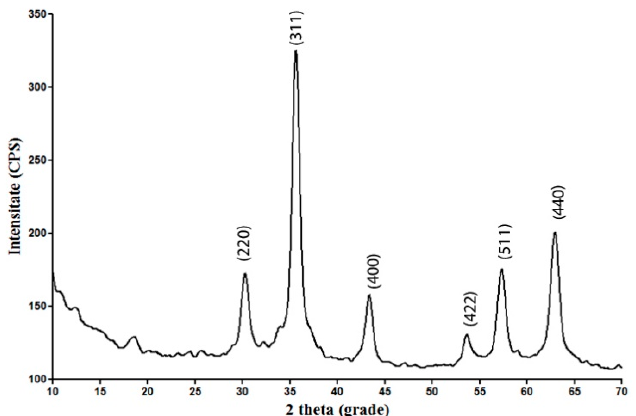
Figure 1. X-ray diffractogram of Fe 3 O 4 @CS nanoparticles.